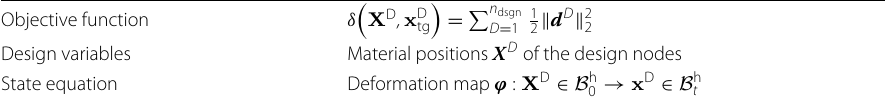
Table1 The node-based optimization problem for inverse form finding [5] Objective